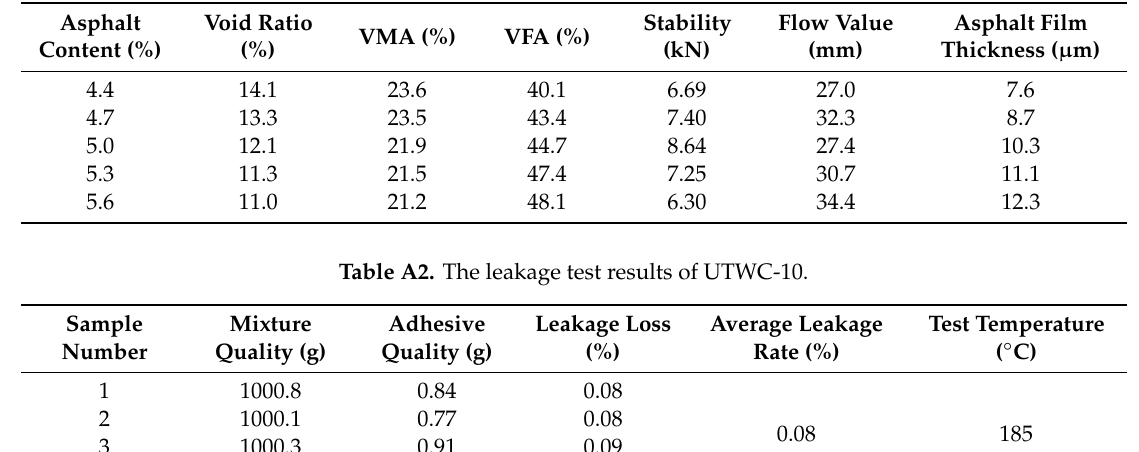
Table A1. The volume parameters of UTWC-10.